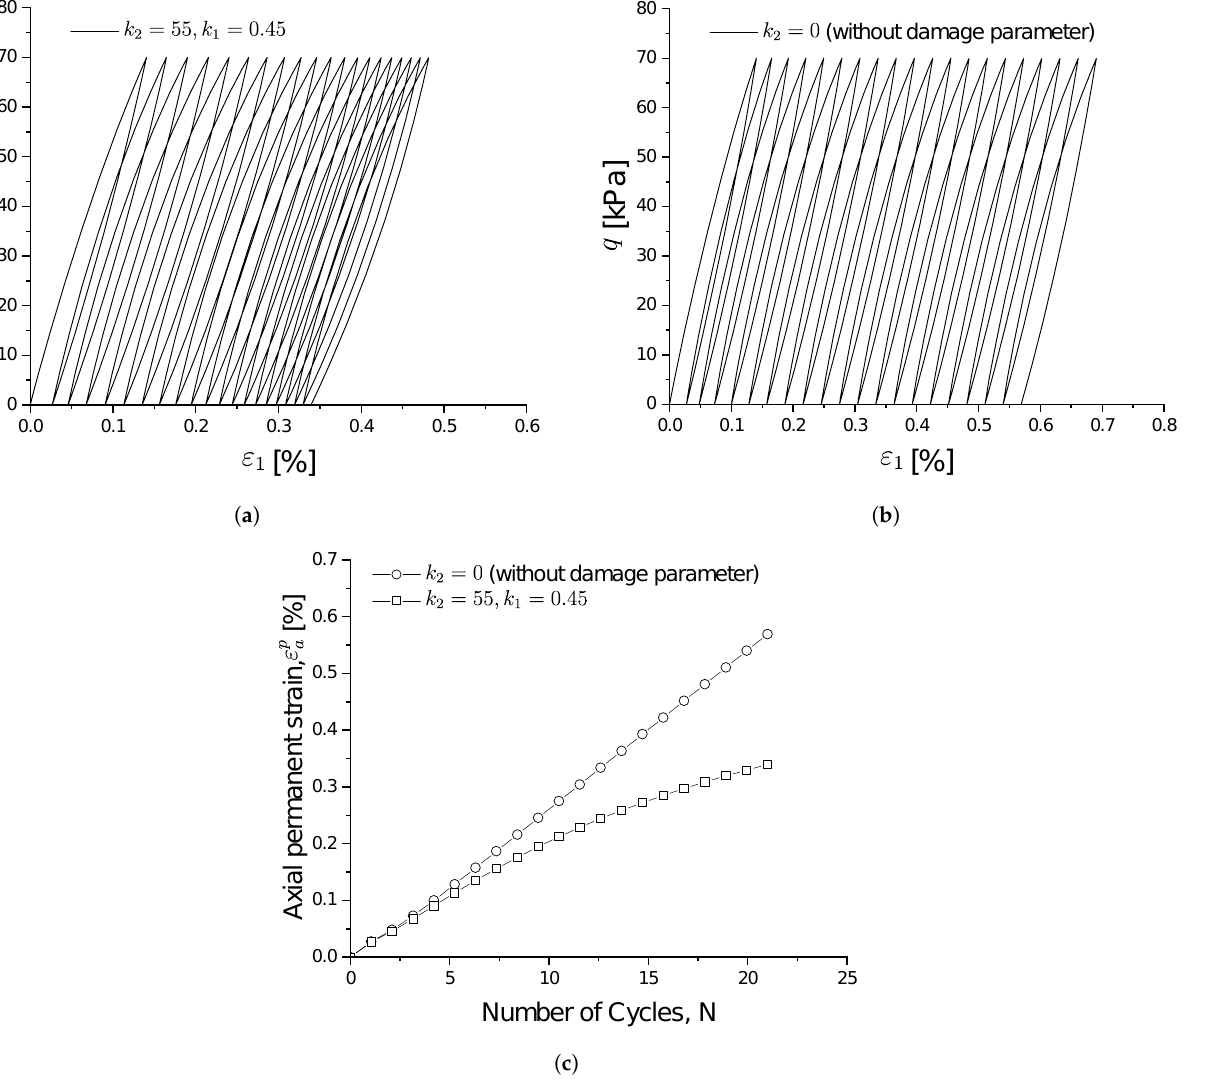
Figure 9. Influence of damage factor d . ( a ) with damage factor, ( b ) without damage factor, ( c ) influence of damage factor on the permanent soil strain under cyclic